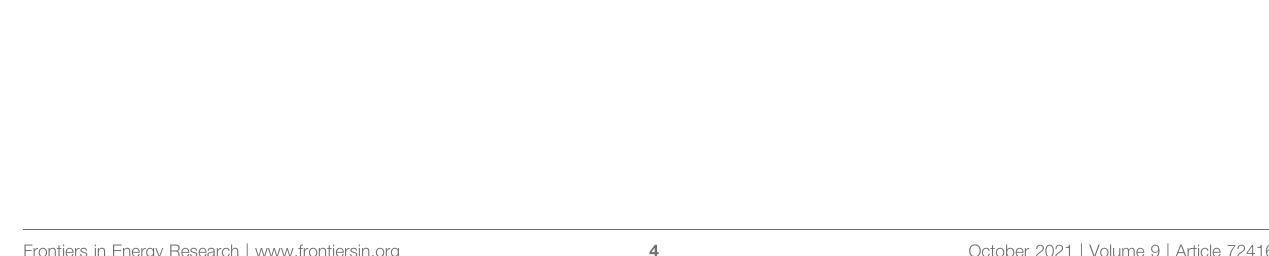
Frontiers in Energy Research |